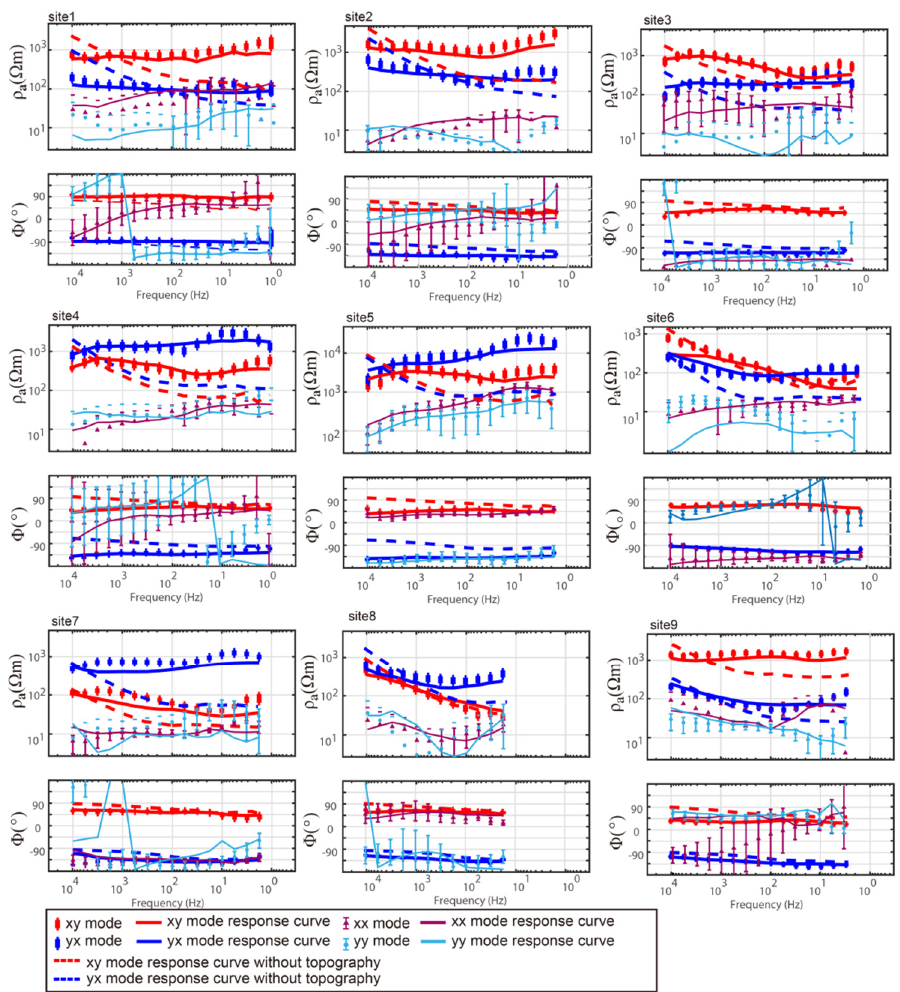
Figure 4. Typical apparent resistivity and phase curves of the research area (scatter), response curves of the 3D inversion model (solid line), and response curves of the 3D inversion model without topography (dashed line). Site1 and Site9 are located in the northern and southern margins of the research area, respectively. Site2 − Site4 are located in copper-single-anomaly area. Site5–Site8 are located near the proven copper mineralization zone (Figure 3b). Some data plots for the diagonal components are also